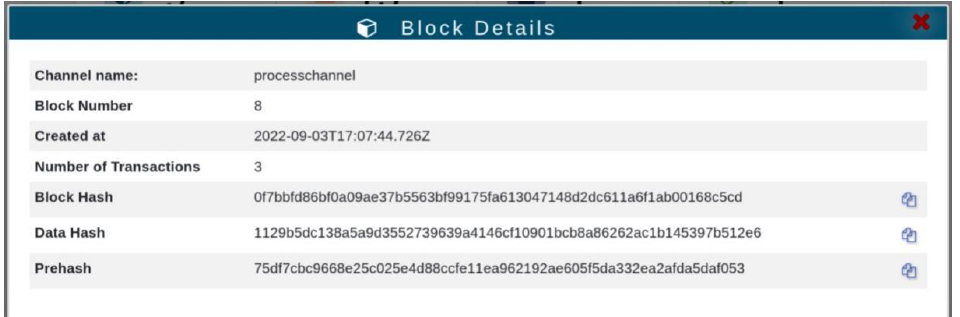
Figure 7. Block information generated by channels in discrete workshops. Appl. Sci. 2022 , 12 , x FOR PEER REVIEW